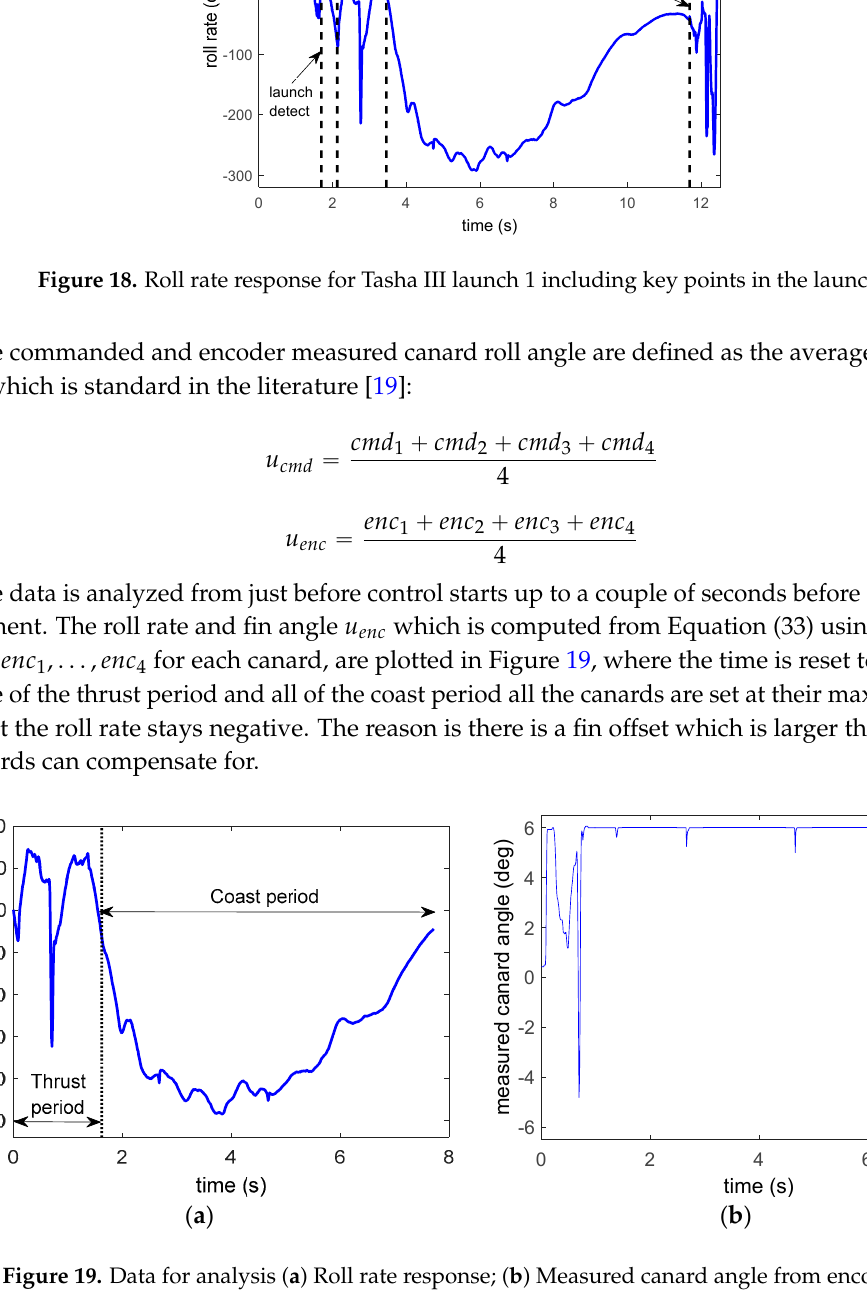
from the roll model of